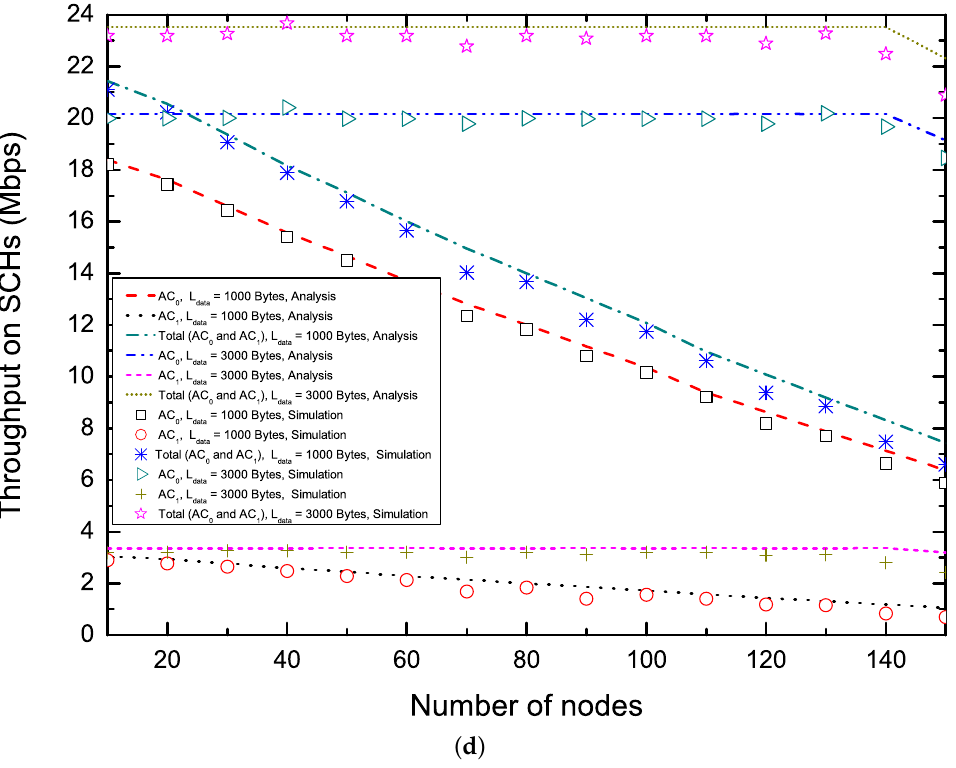
Figure 5. Saturation throughput on SCHs. ( a ) Saturation throughput versus R S ( b ) Saturation throughput versus R S ( N 0 = 40, N 1 = 60); ( c ) Saturation throughput versus the 0 / S 1 number of nodes ( N 0 = N 1 , R S = 2); ( d ) Saturation throughput versus the number of nodes ( N 0 = N 1 , 0 / S 1 R S = 0 / S 1